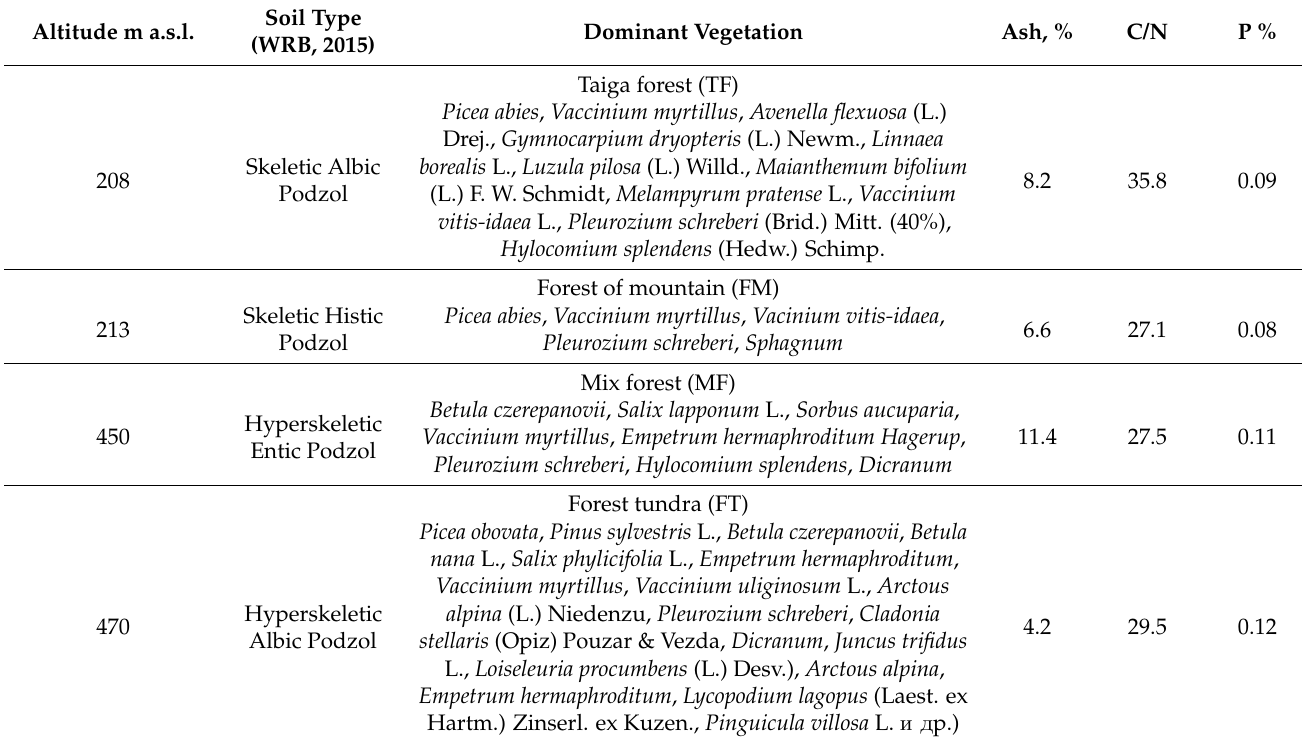
Table 1. Characteristics of sites and soils of taiga forest (TF), forest of mountain (FM), mixed forest (MF), and forest tundra (FT) located along the southwest slope of Mt. Kivakka (208470 m a.s.l.). Altitude m